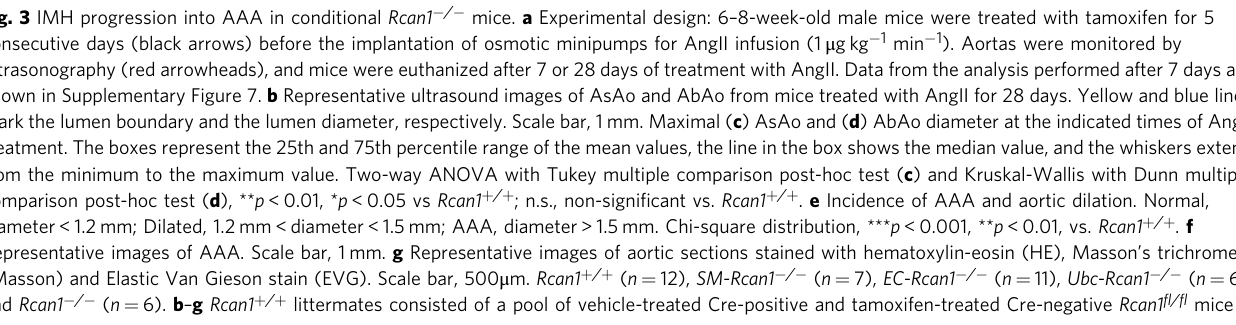
Fig. 3 IMH progression into AAA in conditional Rcan1 − / − mice. a Experimental design: 6 – 8-week-old male mice were treated with tamoxifen for 5 consecutive days (black arrows) before the implantation of osmotic minipumps for AngII infusion (1 μ g kg − 1 min − 1 ). Aortas were monitored by ultrasonography (red arrowheads), and mice were euthanized after 7 or 28 days of treatment with AngII. Data from the analysis performed after 7 days are shown in Supplementary Figure 7. b Representative ultrasound images of AsAo and AbAo from mice treated with AngII for 28 days. Yellow and blue lines mark the lumen boundary and the lumen diameter, respectively. Scale bar, 1 mm. Maximal ( c ) AsAo and ( d ) AbAo diameter at the indicated times of AngII treatment. The boxes represent the 25th and 75th percentile range of the mean values, the line in the box shows the median value, and the whiskers extend from the minimum to the maximum value. Two-way ANOVA with Tukey multiple comparison post-hoc test ( c ) and Kruskal-Wallis with Dunn multiple comparison post-hoc test ( d ), ** p < 0.01, * p < 0.05 vs Rcan1 + / + ; n.s., non-signi fi cant vs. Rcan1 + / + . e Incidence of AAA and aortic dilation. Normal, diameter< 1.2 mm; Dilated, 1.2 mm < diameter < 1.5 mm; AAA, diameter > 1.5 mm. Chi-square distribution, *** p < 0.001, ** p < 0.01, vs. Rcan1 + / + . f Representative images of AAA. Scale bar, 1 mm. g Representative images of aortic sections stained with hematoxylin-eosin (HE), Masson ’ s trichrome (Masson) and Elastic Van Gieson stain (EVG). Scale bar, 500 μ m. Rcan1 + / + ( n = 12), SM-Rcan1 − / − ( n = 7), EC-Rcan1 − / − ( n = 11), Ubc-Rcan1 − / − ( n = 6), and Rcan1 − / − ( n = 6). b – g Rcan1 + / + littermates consisted of a pool of vehicle-treated Cre-positive and tamoxifen-treated Cre-negative Rcan1 fl /